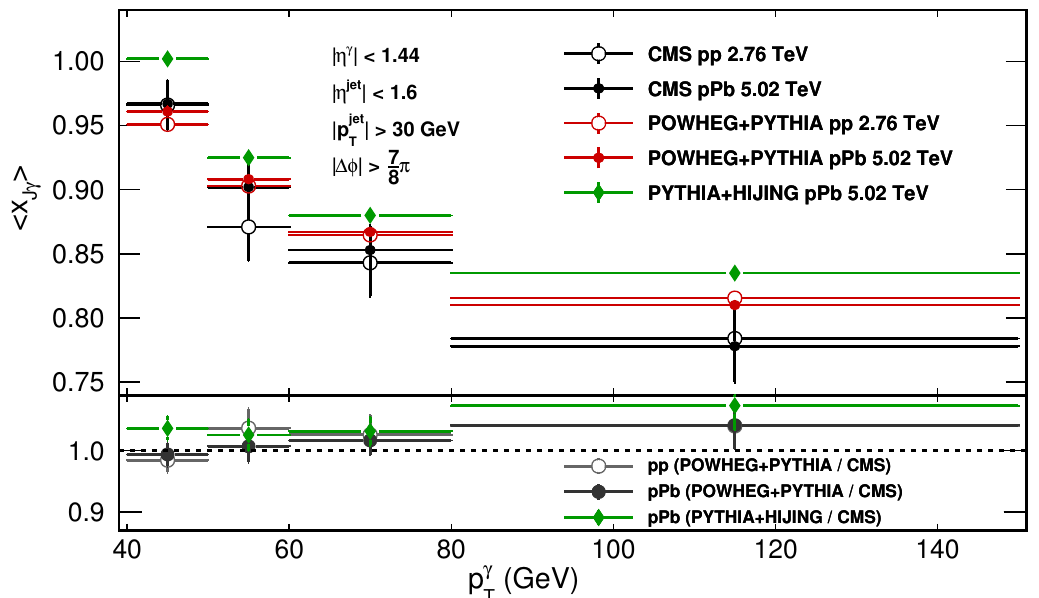
Figure 5 . Average jet transverse momentum fraction as a function of photon transverse momentum. CMS 2013 data (black) are compared to predictions in LO with PYTHIA+HIJING (green) and NLO+PS with POWHEG+PYTHIA (red). The rightmost p (cid:13) bound). The lower panel shows the ratio of theory over data for pp (open circles) and pPb (full circles and green diamonds), which coincide partially for the largest p (cid:13)